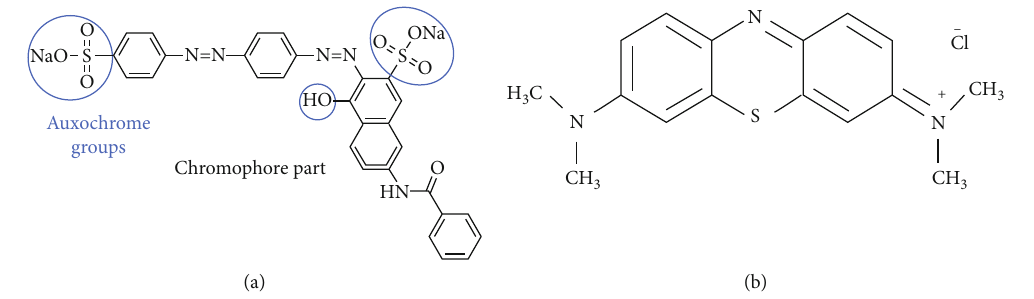
Figure 1: Structures of (a) direct red-81 and (b) methylene